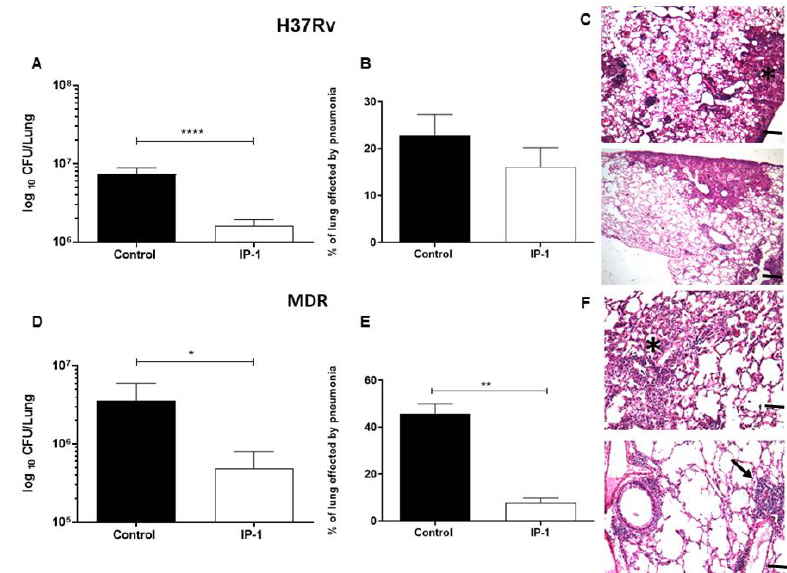
Figure 7. E ff ect of IP-1 treatment in BALB / c mice at 60 days post-infection with the drug-sensitive or drug resistant MTB strains. ( A ) Groups of mice infected with drug sensitive H37Rv strain were treated with 8 µ g of IP-1 by intratracheal route each other day during one month, right lung was used to determinate bacillary loads by colony forming units (CFU), treated mice showed a significant decrease of live bacilli in comparison with control mice. ( B ) Left lungs were perfused with formaldehyde and used to determine pneumonia by automated morphometry, in comparison with control mice, a non-significant decrease of lung consolidation was seen in treated animals. ( C ) Representative micrographs of control non-treated mouse infected with H37Rv strain (top figure) shows similar lung surface area a ff ected by pneumonia (asterisk) that in mouse treated with IP-1 (bottom figure). ( D ) The same treatment in mice infected with MDR strain showed a significant decrease of bacillary loads and lung surface a ff ected by pneumonia. ( E ) Asterisk represents statistical significance ( p < 0.05). ( F ) Representative micrograph of control non-treated mouse infected with MDR strain showing areas of pneumonia (asterisk, top figure), in comparison with MDR infected mouse treated with IP-1 that exhibits small patches of pneumonia (arrow, bottom figure) and perivascular inflammation (H / E staining, magnification 100 × ). The images correspond with one representative experiment. The bars in images ( C ) and ( F ) represent 200 µ m. Asterisk represents statistical significance (* p < 0.05, ** p < 0.003, **** p <